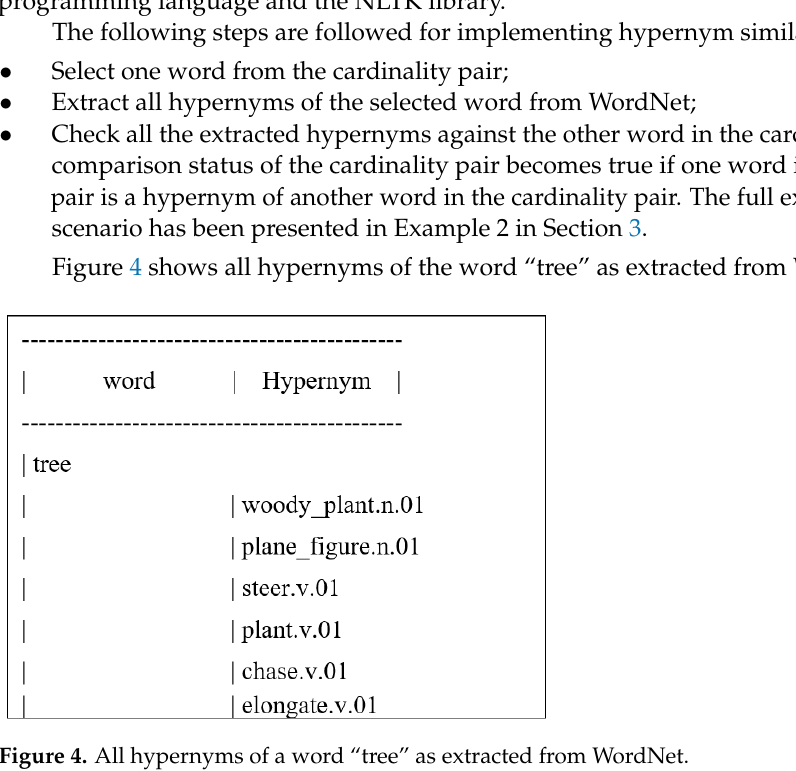
Figure 5. Algorithm for calculating hypernym similarity between classes “A” and “B” and classes “B” and “A”. The algorithm in Figure 5 implements Example 2 using the Python programming language and the NLTK library. The implementation of these two algorithms demon- strates the theoretical and practical applicability of our proposed approach. 5. Evaluation